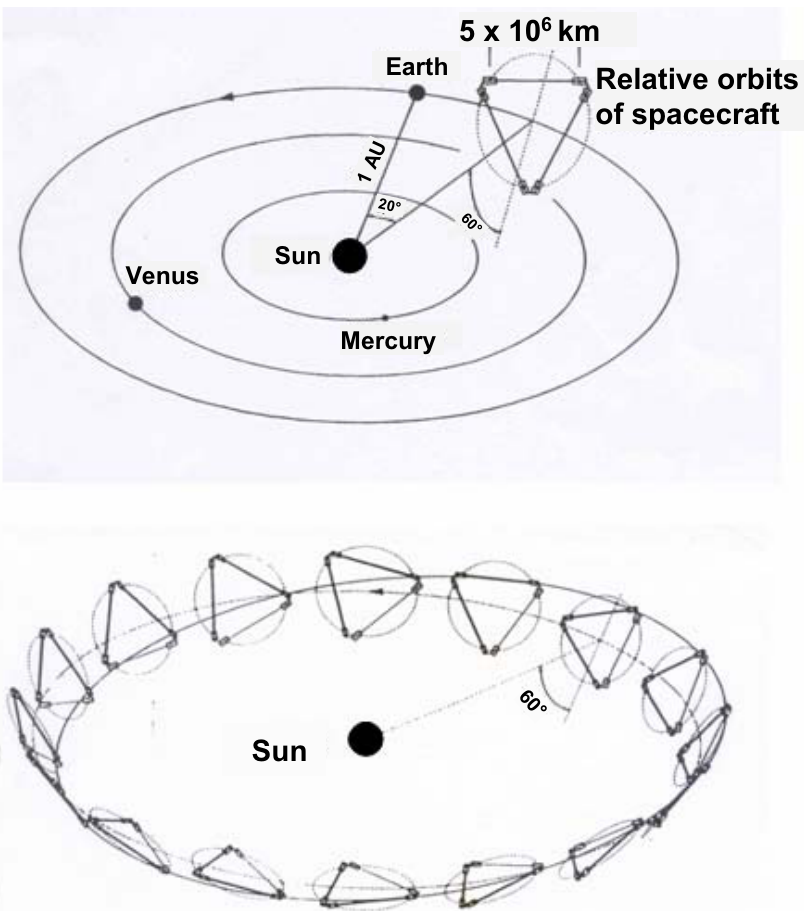
Fig. 5 – The LISA interferometer, which ‘‘tumbles’’ as it orbits the Sun, trailing the Earth by 20degreesonthesameorbit. The60-degreeinclinationoftheplaneoftheinterferometerwith respect to the ecliptic is chosen to minimize the relative displacement of the 3 spacecrafts, which follow similar, but different orbits that are slightly inclined against the ecliptic. The tumbling varying orientation of the plane of the interferometer will help in determining direction and polarization. The size of the detector is not in scale with the orbit!